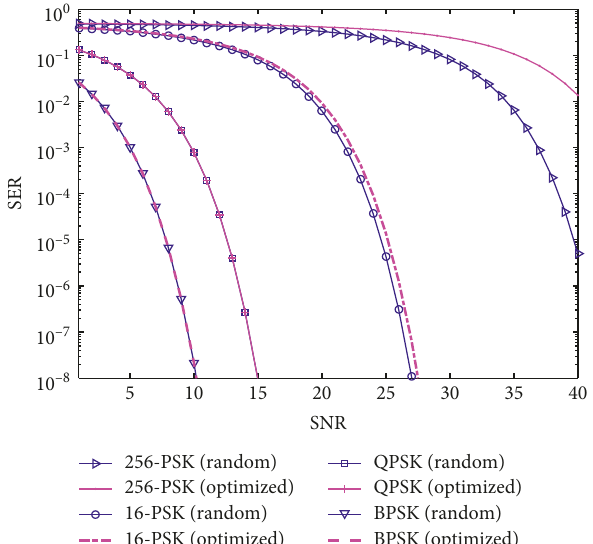
Figure 10: Comparative SER performance of BPSK, QPSK, 16-PSK, and 256-PSK.